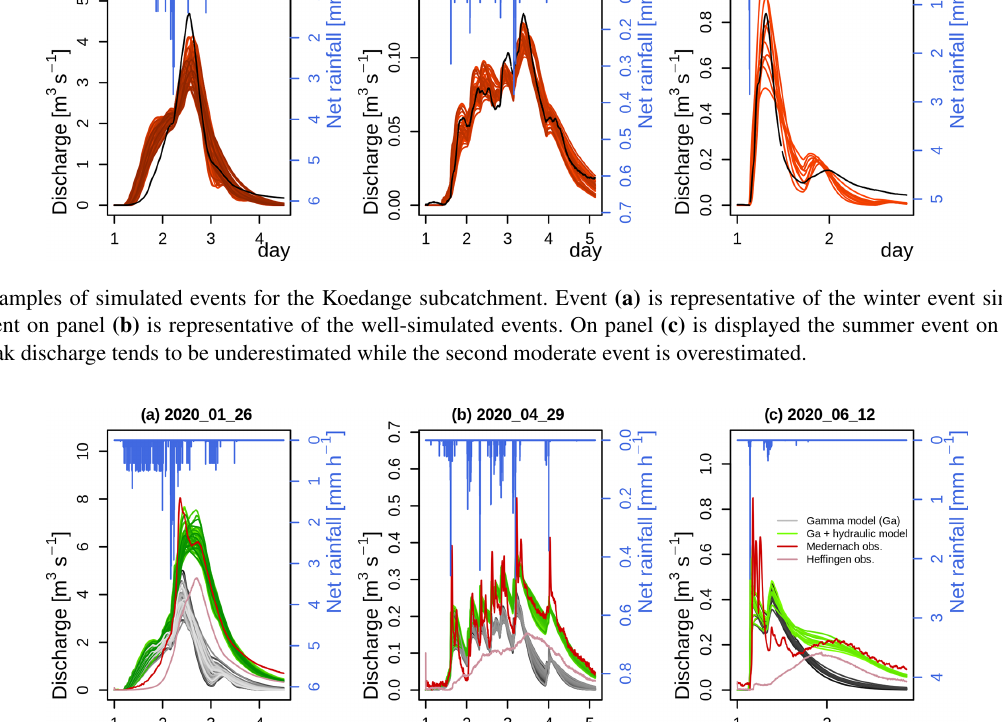
(end of October, November) and the drying out in spring (end of March, April) have the lowest VOL1h (7 . 2 ± 2 . 7